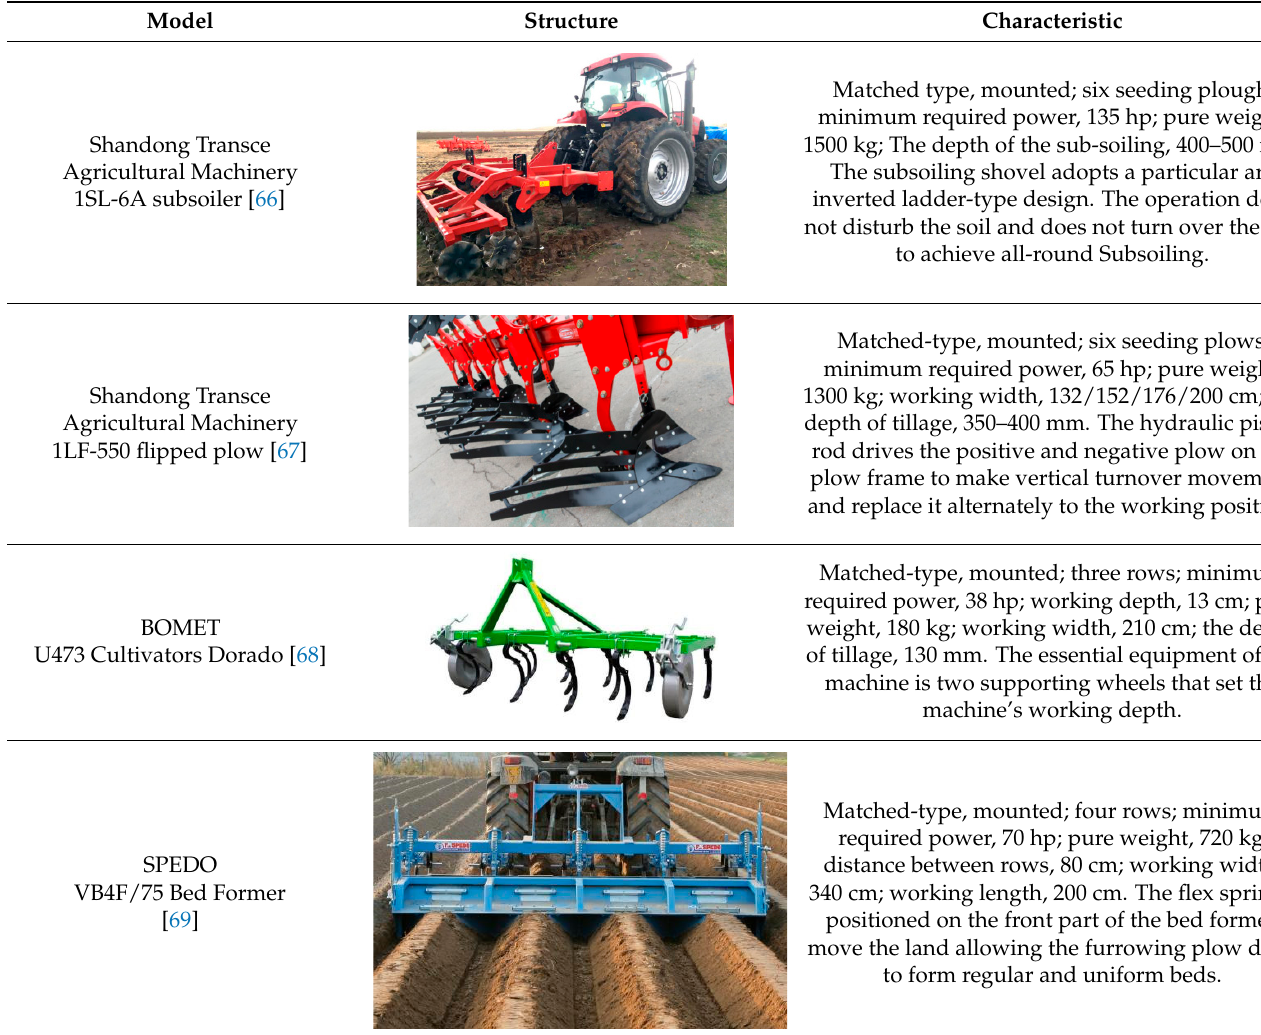
Table 4. Some typical soil preparation Table 4. Some typical soil preparation machines. Table 4. Some typical soil preparation machines. Table 4. Some typical soil preparation machines. Table 4. Some typical soil preparation machines.